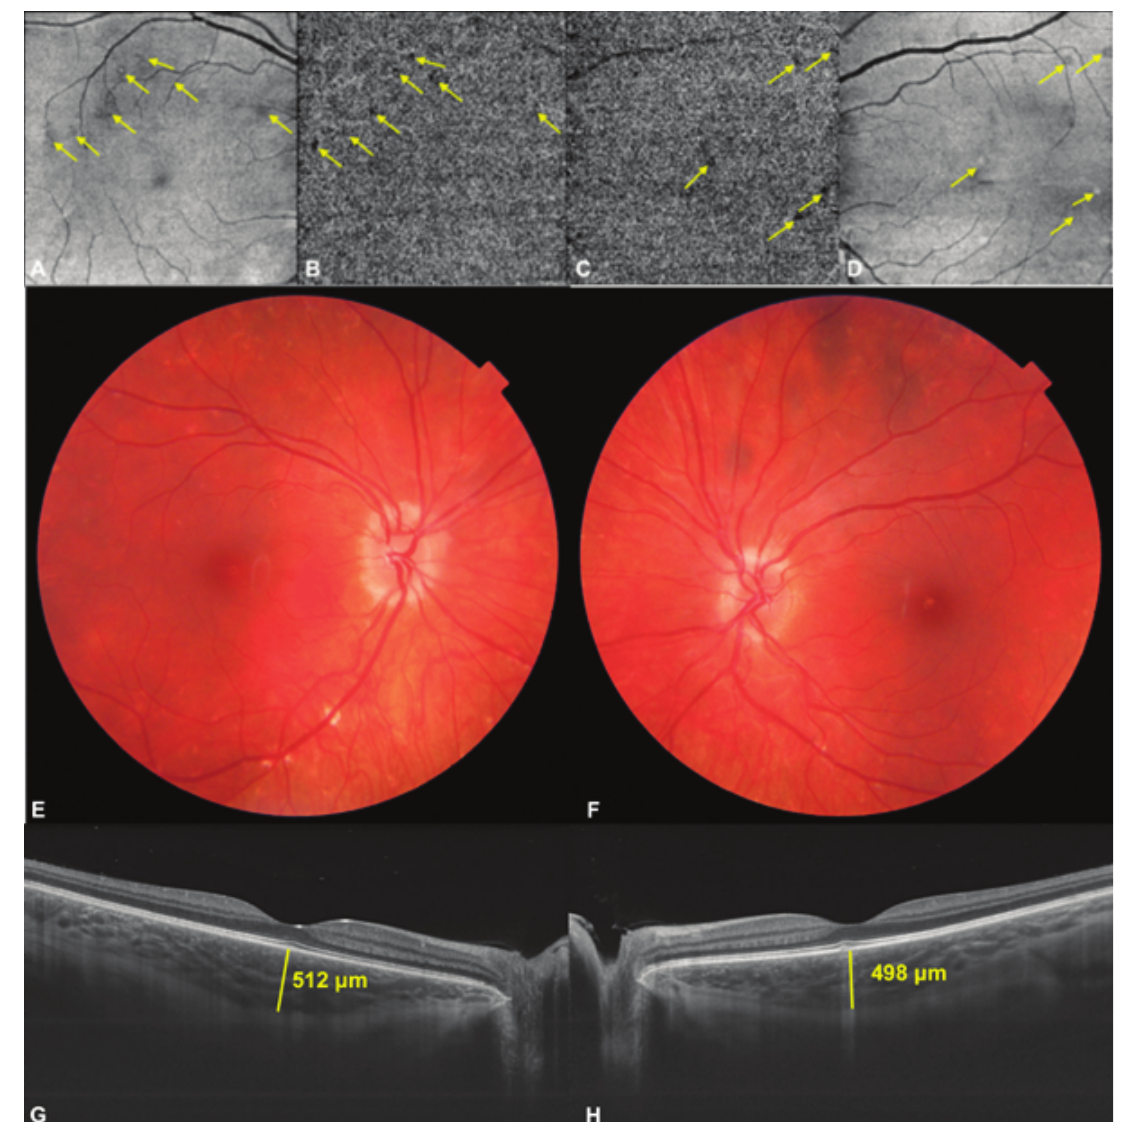
Figure 3. (A&B) Choriocapillaris slab of montage optical coherence tomography angiography and en-face OCT image of the right. (C&D) Left eyes revealing the patchy ischemia of choriocapillaris (arrows). Color fundus pictures taken at the last visit showing slightly blurred disc margins with less apparent old scars with no new lesion. (E) Right eye and (F) left eye. (G) Swept source optical coherence tomographic subfoveal choroidal thickness was 512 μm in the right eye and (H) 498 μm in the left